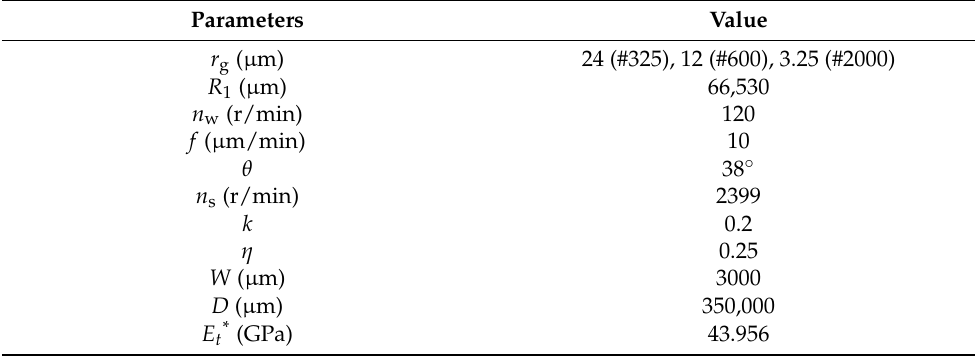
Table 5. Grit cutting depth model parameter values.